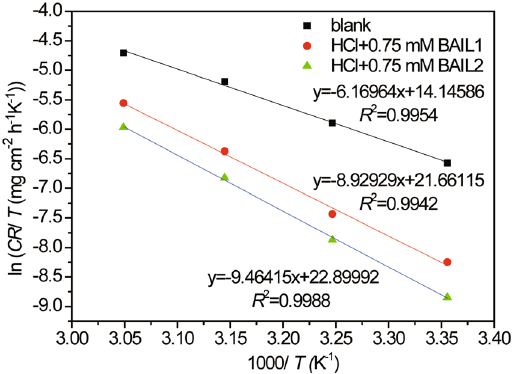
Figure 10. Plot of ln( CR / T ) vs. 1000/T for carbon steel in 0.5 M HCl solution without BAILs ( ) and with 0.75 mM of BAIL1 ( ) and BAIL2 ( ).